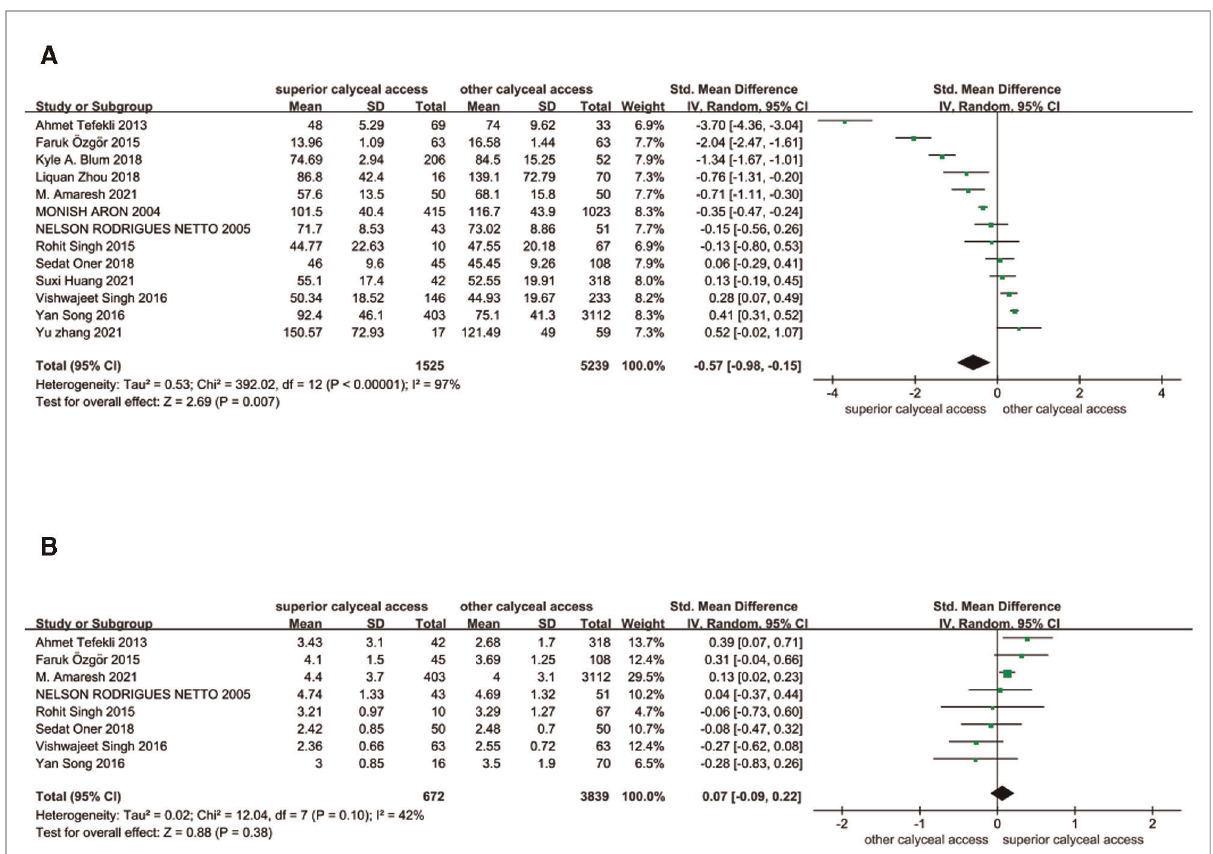
FIGURE 3 Forest plots of meta-analysis. ( A ) Operation time comparison between superior calyceal access and other calyceal access. ( B ) Hospital stays comparison between superior calyceal access and other calyceal